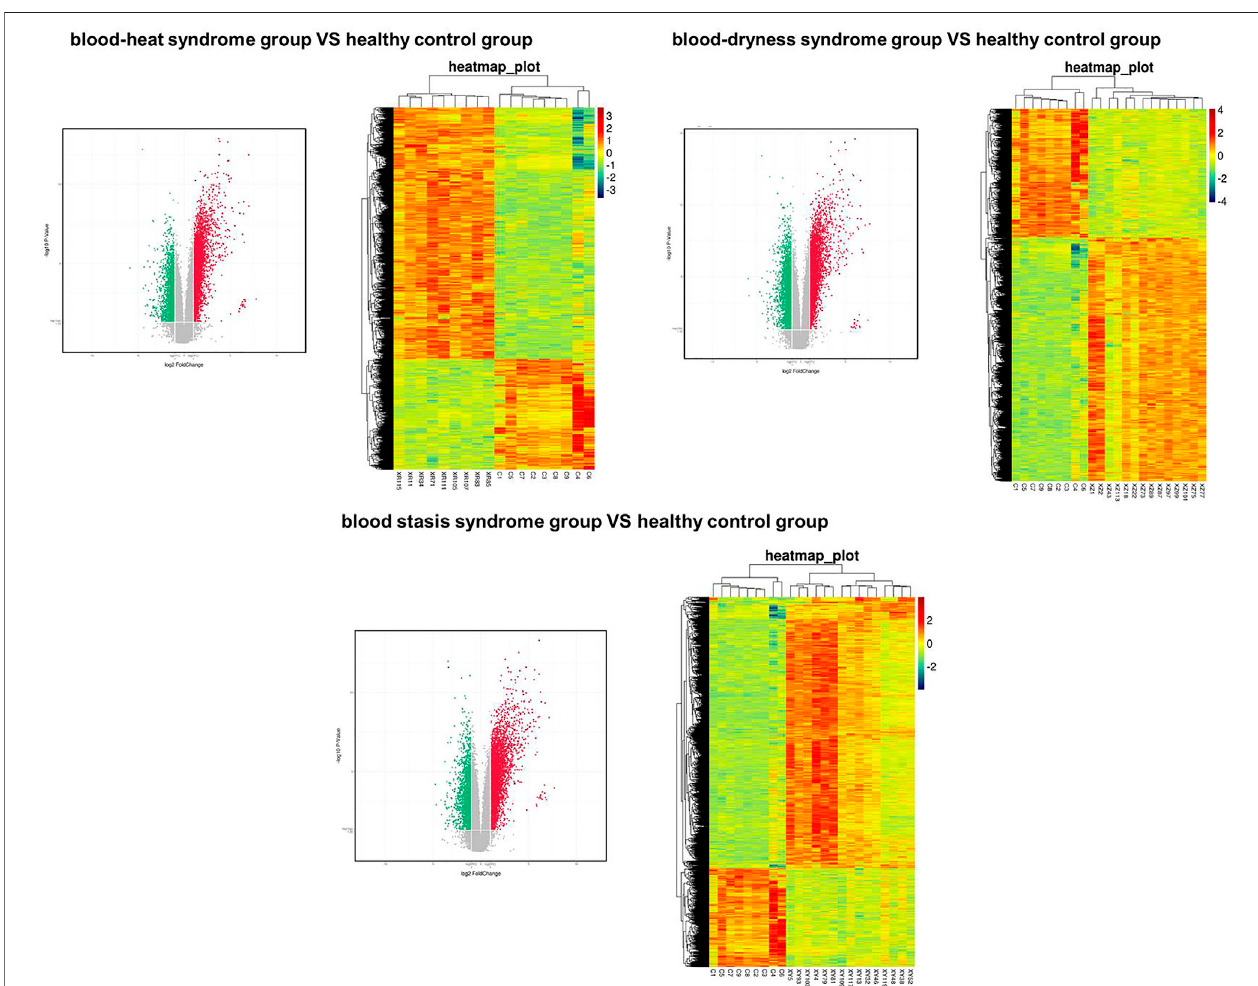
FIGURE 1 | Volcanic map (left panel) and heat map (right) showed the distributions of genes in different syndromes.